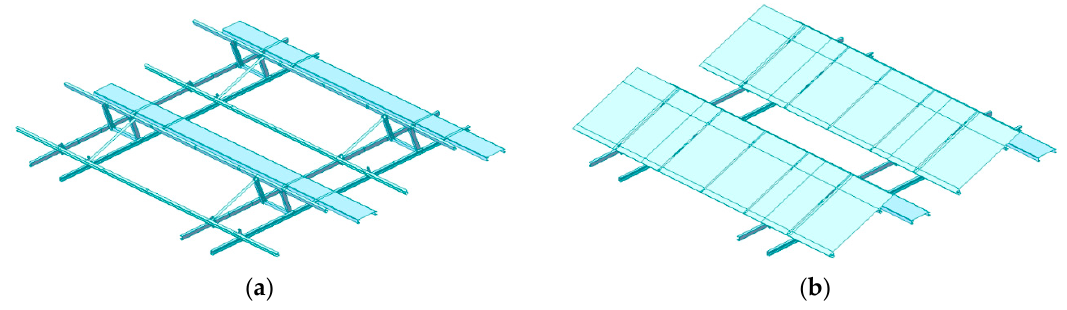
Figure 10. Modeling. ( a ) Frame; ( b ) photovoltaic module.